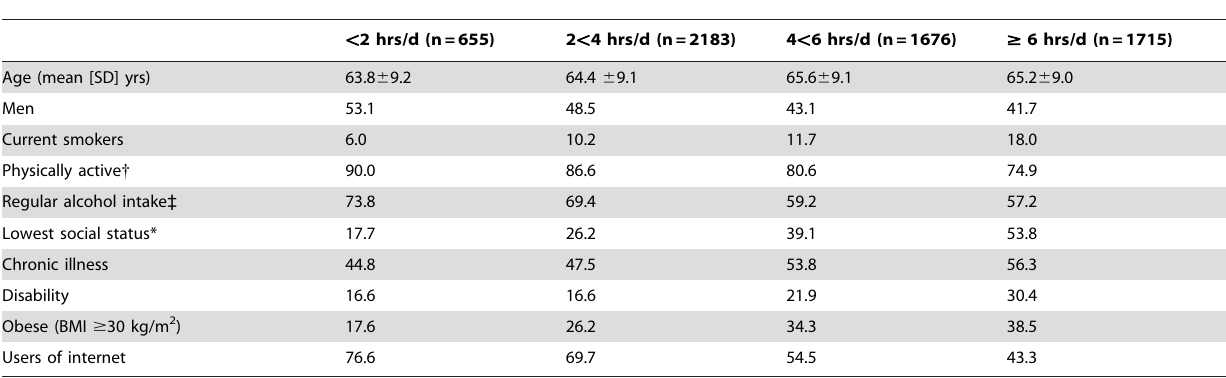
Table 1. Characteristics of the sample in relation the TV viewing time.